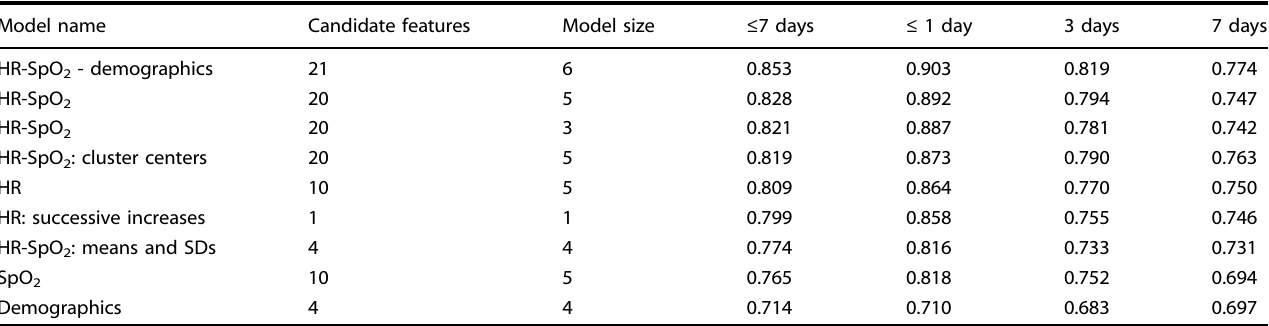
Fig. 3 Three representative clusters of operations and their relations to each other. Each dot represents an individual operation. The colors — green, blue, and red — represent the three clusters; several individual operations are labeled. The green group represents measures of the maximum of the heart rate, the blue group reports on the mean oxygen saturation, and the red group reports on the standard deviation of the heart rate. The black lines indicate pairings between operations in the same cluster, whereas the very short red line indicates the small number of pairings between operations from different clusters. heart rate heart rate; STD standard deviation. Table 3. Model performances as a function of days until